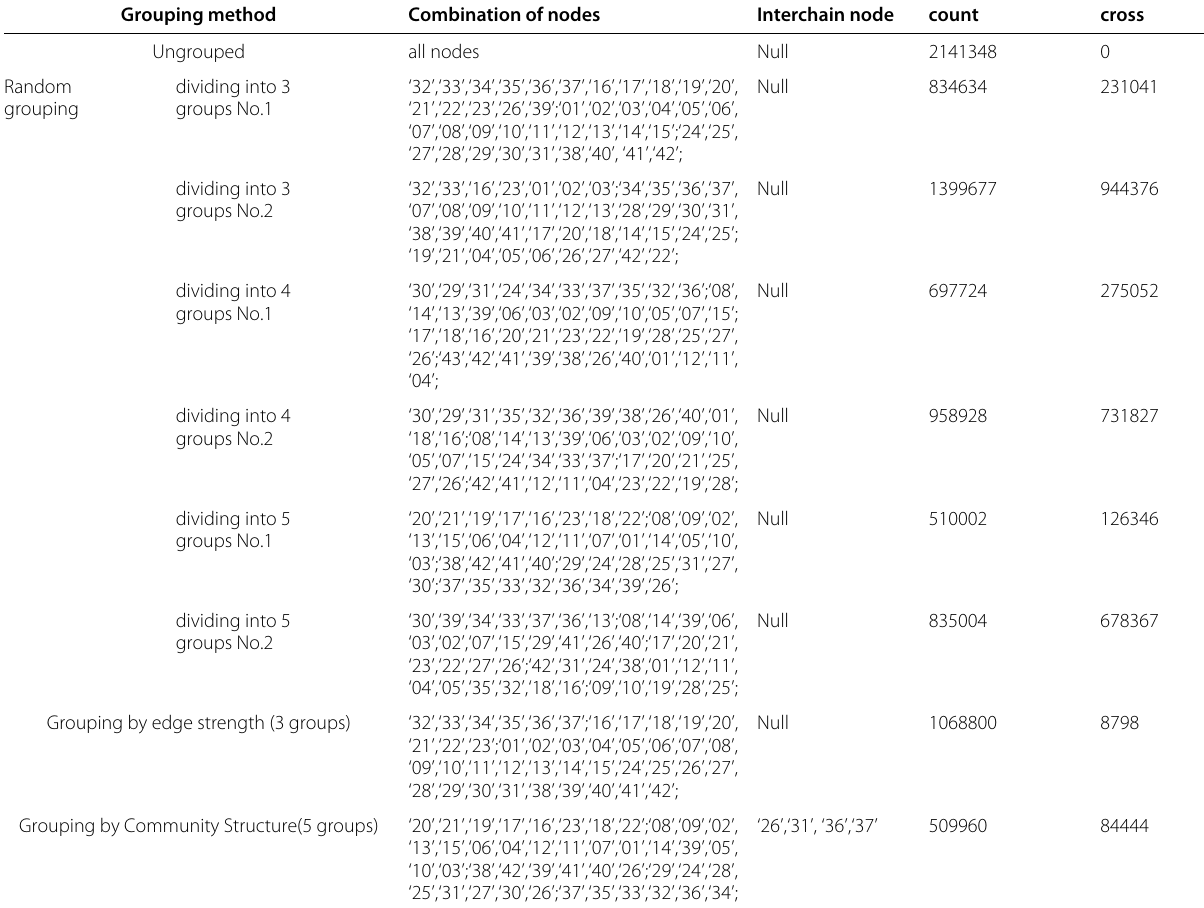
Table 1 Statistics of the results of the partition of